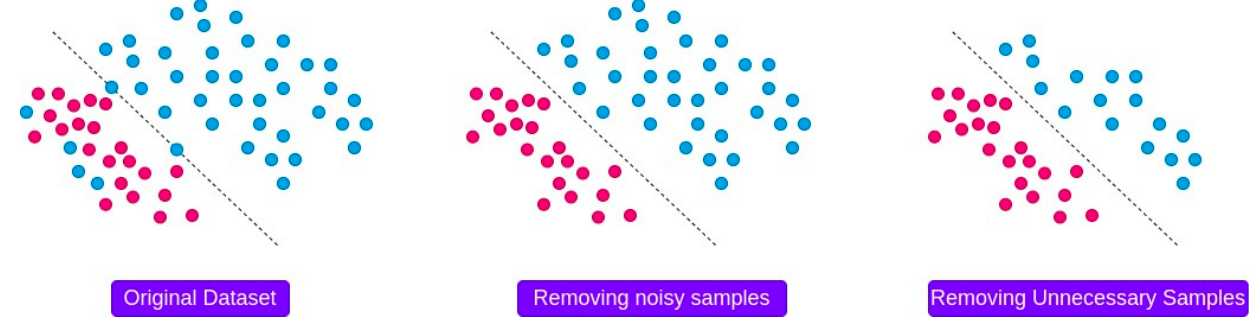
Figure 7. Illustration of One-Sided Selection. Through a modification of the condensed closest neigh- bor rule, this method preserves the entirety of the minority class samples while eliminating the redundant majority class samples.